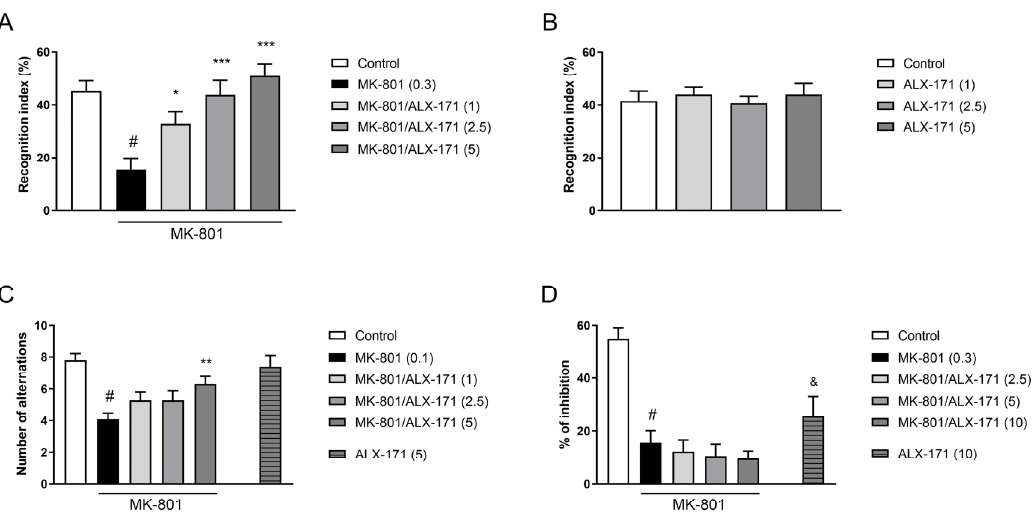
Figure 10. The effect of ALX-171 on MK-801-induced deficits ( A ) or in naïve mice ( B ) in the NOR test. The effect of ALX-171 on MK-801-induced deficits in the spatial delayed alternation test ( C ) and prepulse inhibition ( D ). Doses are indicated in parentheses as mg/kg. The data are presented as means ± SEM. ( A ) One-way ANOVA: F (3.36) = 10.08, p < 0.0001; * p < 0.05; *** p < 0.001 vs. MK-801- treated group; # p < 0.01 vs. control group. ( C ) One-way ANOVA: F(3.36) = 3.344, p < 0.05; ** p < 0.01 vs. MK-801-treated group; # p < 0.0001 vs. control group. ( D ) Student’s t -test: t = 3.459, df = 26, & p < 0.01 vs. control group; t = 6.272, df =40, # p < 0.0001 vs. control